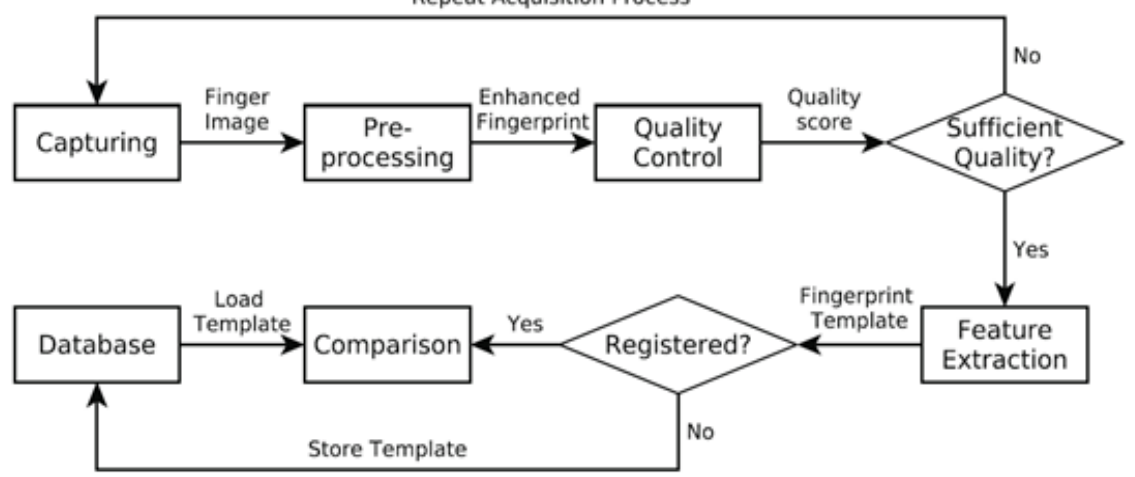
Figure 3. Overview of the sub-systems of a generic contactless fingerprint recognition system [10].